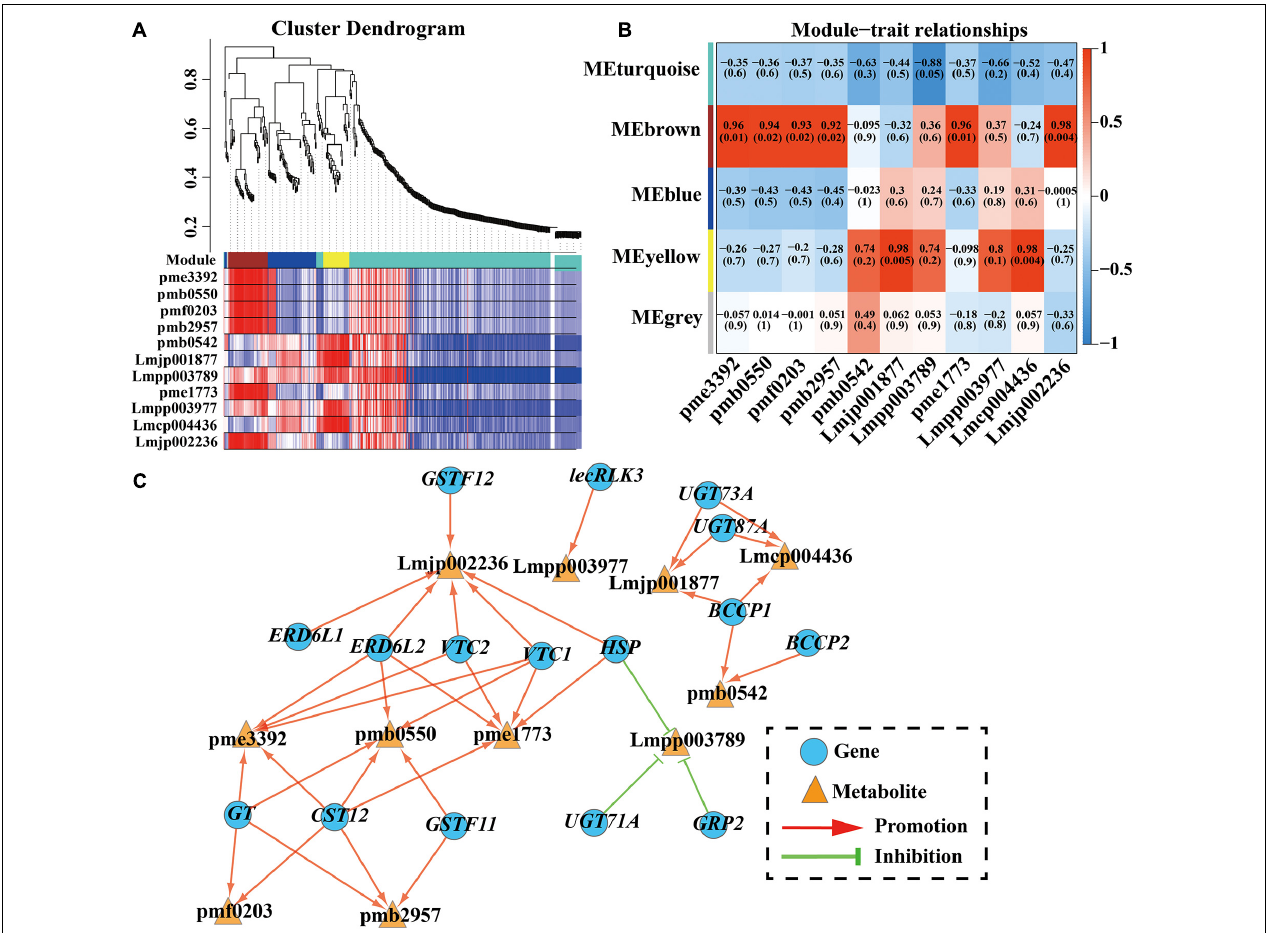
FIGURE 5 | WGCNA results of 634 DEGs (with 11 DAAs PCC ≥ 0.95 or ≤ –0.90). (A) Hierarchical clustering tree (cluster dendrogram) results showed 5 expression modules, labeled with different colors. (B) Module-anthocyanin relationship analysis. The value inside each box represents Pearson’s correlation coefficient between the module with anthocyanin, and the number in each parentheses represents p -value. The color scale on the right represents the degree of correlation between modules and anthocyanins and the red represent high correlation. (C) The directed interaction network diagram between DEGs and anthocyanin. Red line represents the promotion of synthesis, while green “T” represents inhibition of accumulation. Blue circles represent DEGs and orange triangles represent anthocyanin. pme3392, pelargonidin-3- O- glucoside; pmb0550, cyanidin-3- O- glucoside; pmf0203, peonidin-3- O- glucoside; pmb2957, cyanidin- O- syringic acid; pme1773, cyanidin-3- O- (6 (cid:48)(cid:48) - O- malonyl) glucoside; Lmjp002236, cyanidin-3- O- sambubioside; Lmpp003789, cyanidin-3- O- (6 (cid:48)(cid:48) - O- p-Coumaroyl) glucoside; pmb0542, cyanidin-3- O- rutinoside; Lmjp001877, peonidin-3- O- (6 (cid:48)(cid:48) - O- p-Coumaroyl) glucoside; Lmpp003977, cyanidin-3- O- (6 (cid:48)(cid:48) - O- caffeoyl) glucoside; Lmcp004436, cyanidin-3- O- [6 (cid:48)(cid:48) - O- (Z)-p-coumaroyl-2 (cid:48)(cid:48) - O- xylosyl] glucoside-5- O-